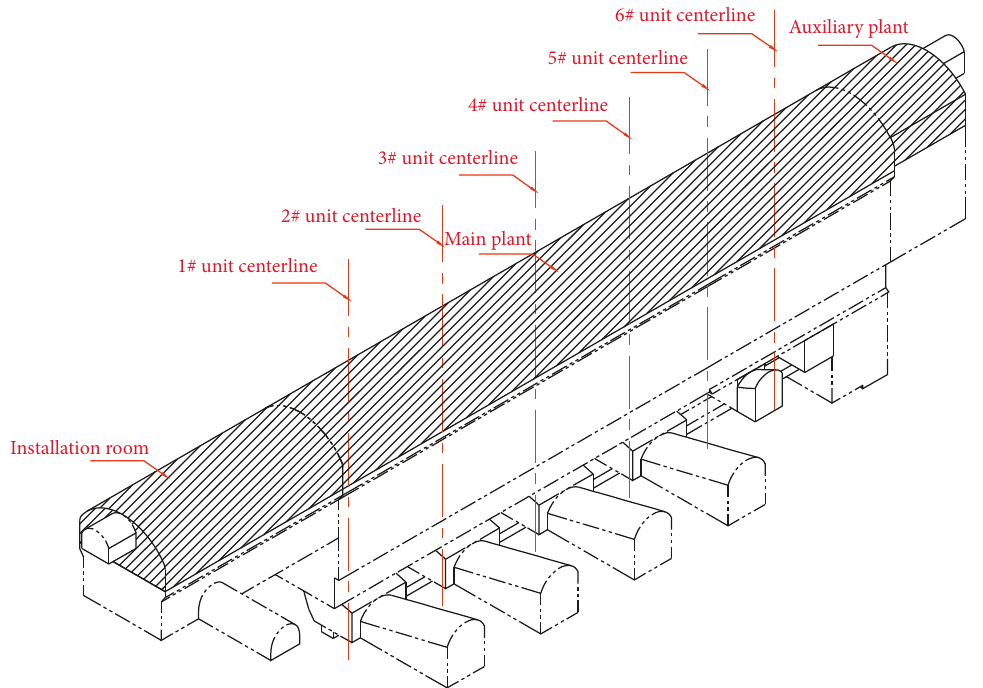
Figure 14: Sectional position diagram of units 1# ∼